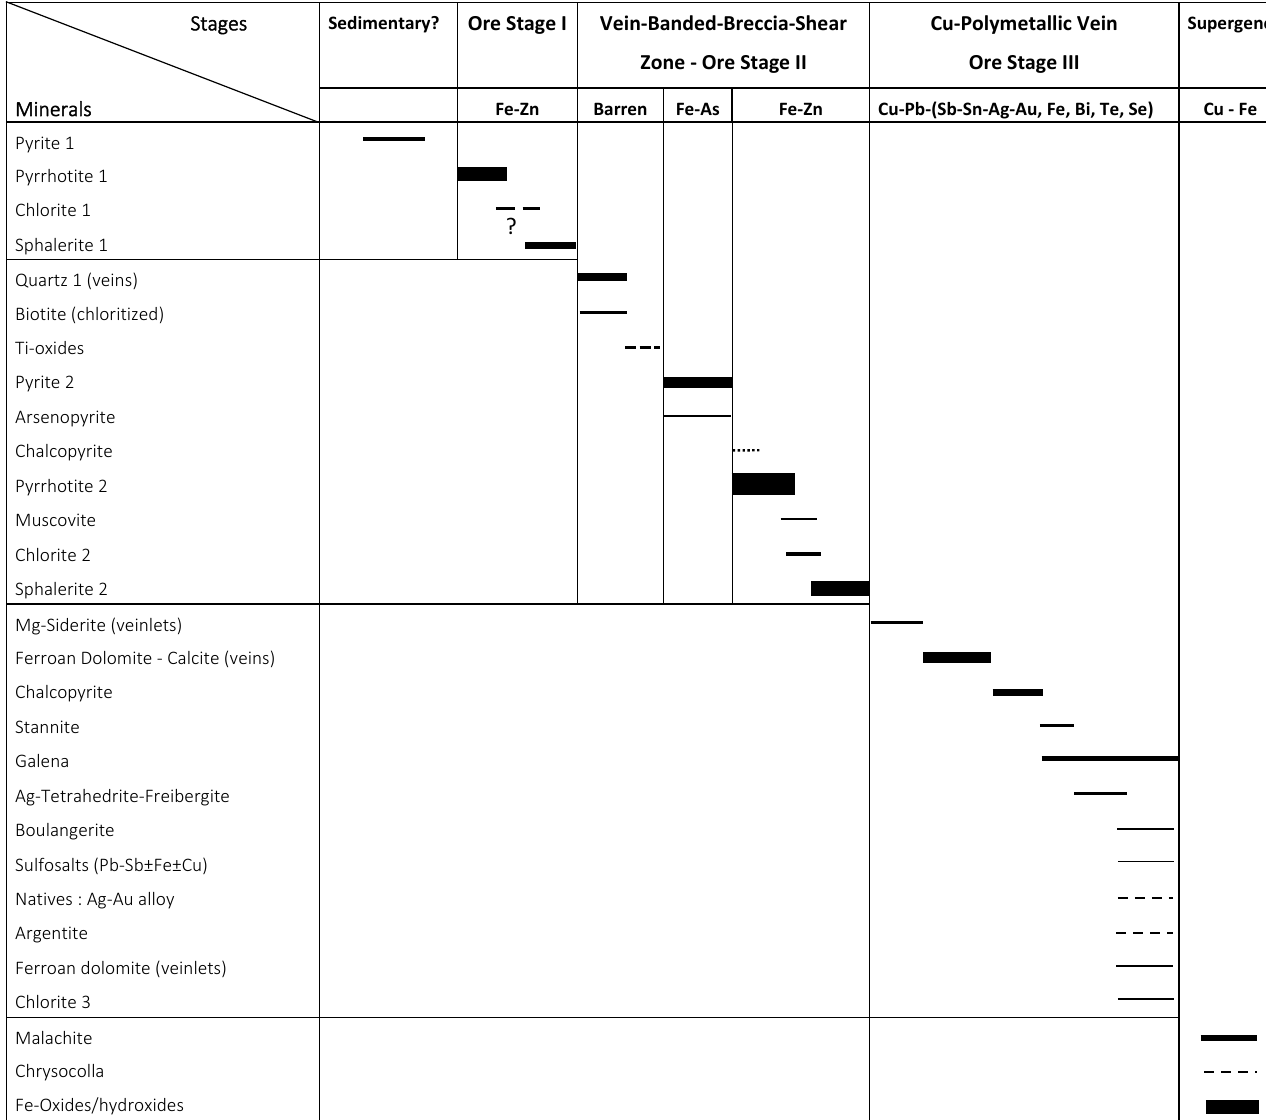
Table 2. Paragenetic sequence for the Koudiat Aïcha deposit.